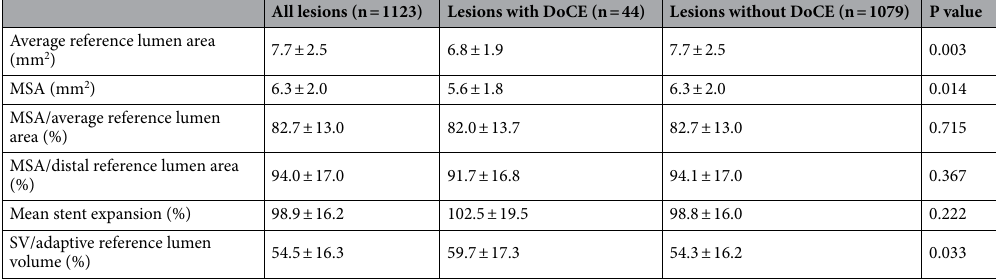
All lesions (n = 1123) Lesions with DoCE (n = 44) Lesions without DoCE (n = 1079) P value Average reference lumen area (mm 2